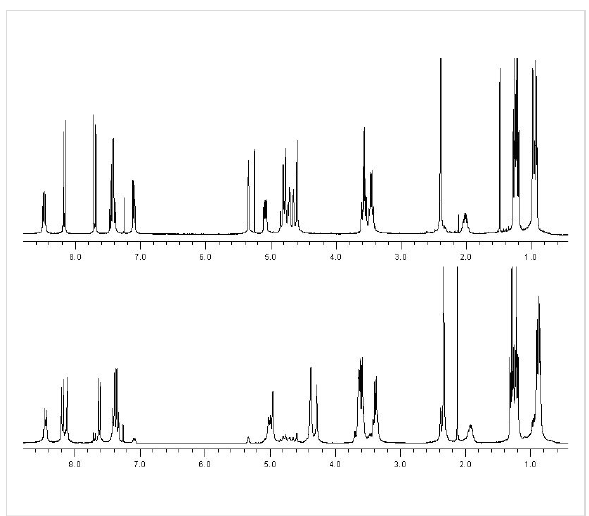
Figure 2: 1 H NMR spectra (300 MHz, CDCl 3 ) of the ether compound 4 (top) and the ligand 1a -H 3